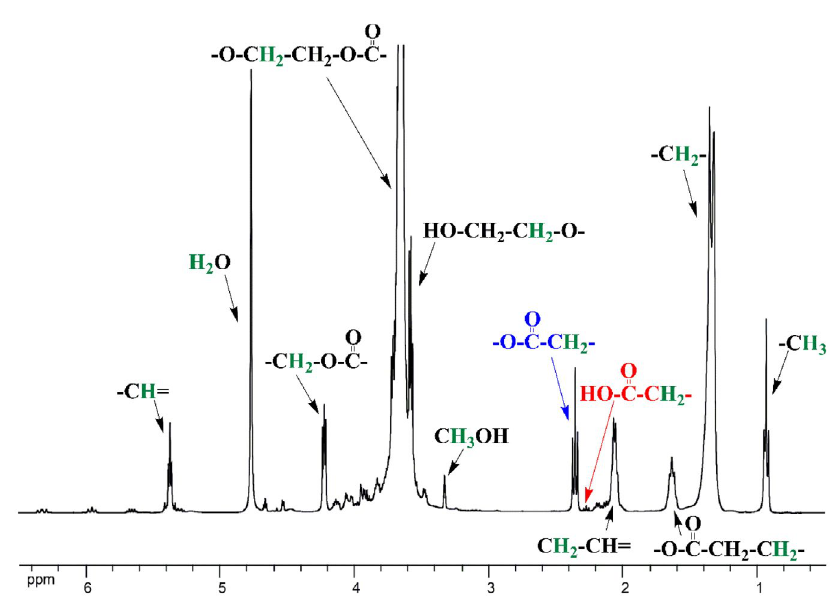
Fig 3. 1 H NMR spectrum of the fresh PS 80 sample recorded in CD 3